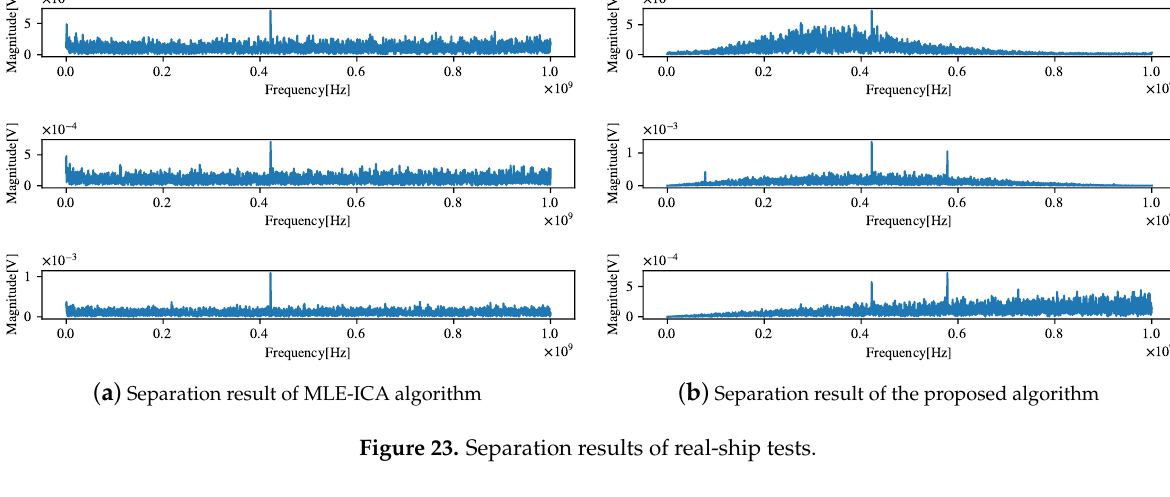
Figure 22. Correlation coefficients between the separation results and the observed signals for each algorithm.